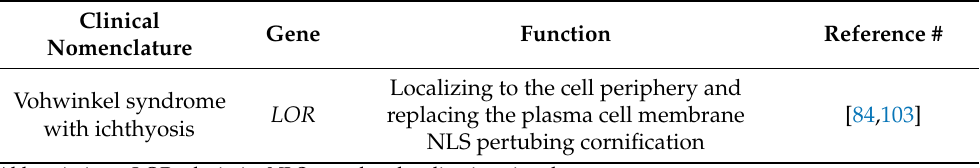
Table 3. Ichthyosiform Dermatosis Caused by LOR